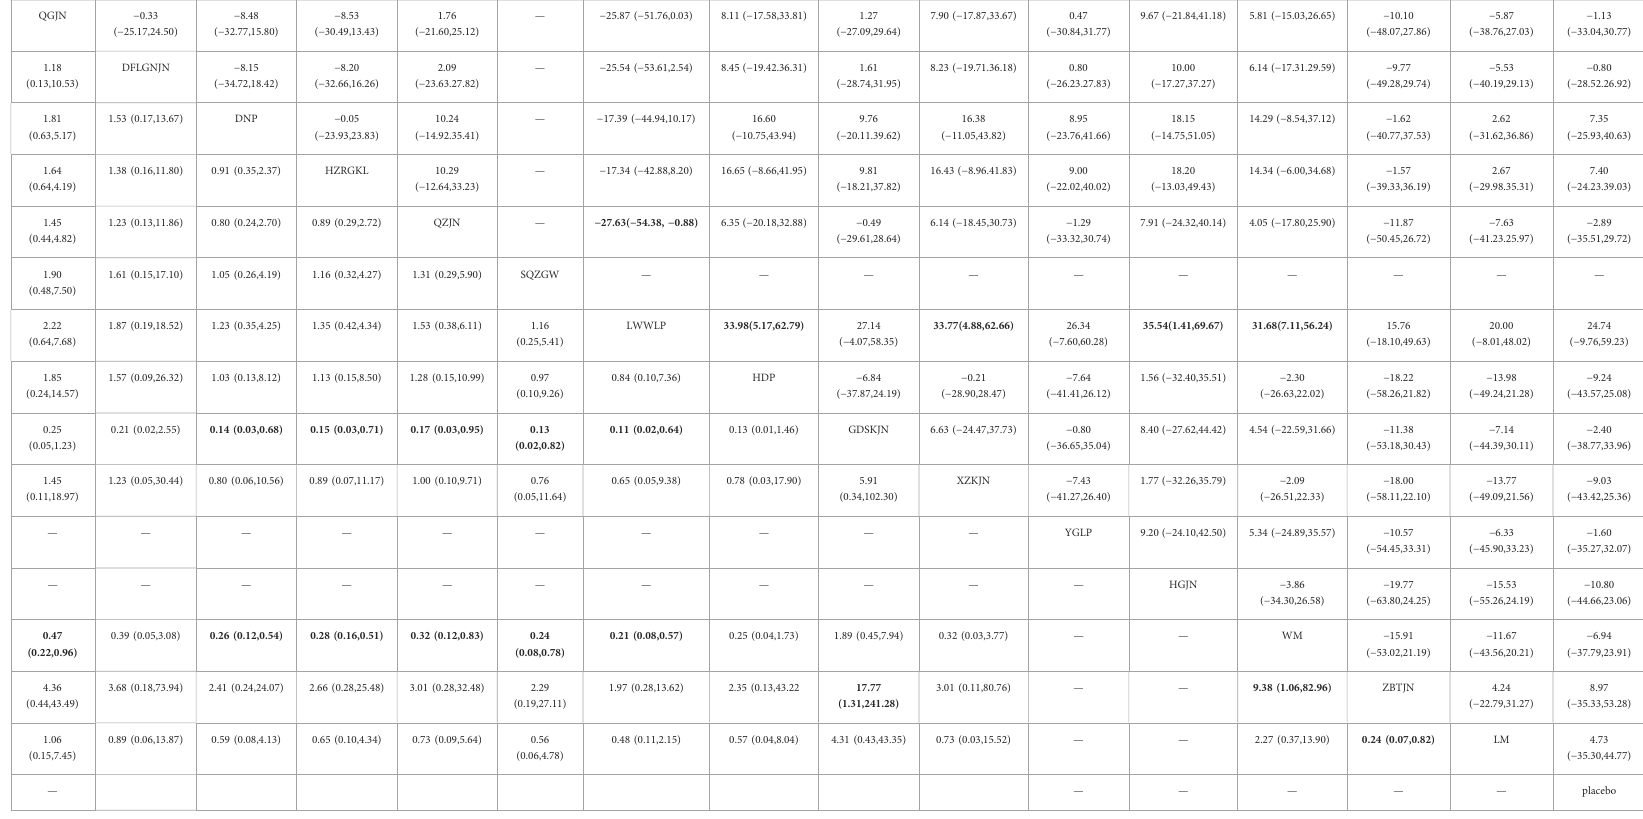
QGJN: Qianggan capsule; DFLGNJN: Dangfei Liganning capsule; DNP: Danning tablet; HZRGKL: Huazhi Rougan granule; QZJN: Qiaozhi capsule; SQZGW: Sanqi Zhigan pill. LWWLP: Liuwei Wuling tablet; HDP: Hedan tablet; GDSKJN: Gandan Shukang capsule; XZKJN: Xuezhikang capsule; YGLP: Yiganling tablet; HGJN: Hugan capsule; WM: Western medicine; ZBTJN: Zhibitai capsule; LM: lifestyle modi fi cation. Data of comparison for Clinical ef fi ciency rate are OR (95%CI). The 95% con fi dence interval which does not range across one favors the column-de fi ning treatment and is shown in bold. Data of comparison for ALT, are MD (95%CI). The 95% con fi dence interval which does not range across 0 favors the column-de fi ning treatment and is shown in